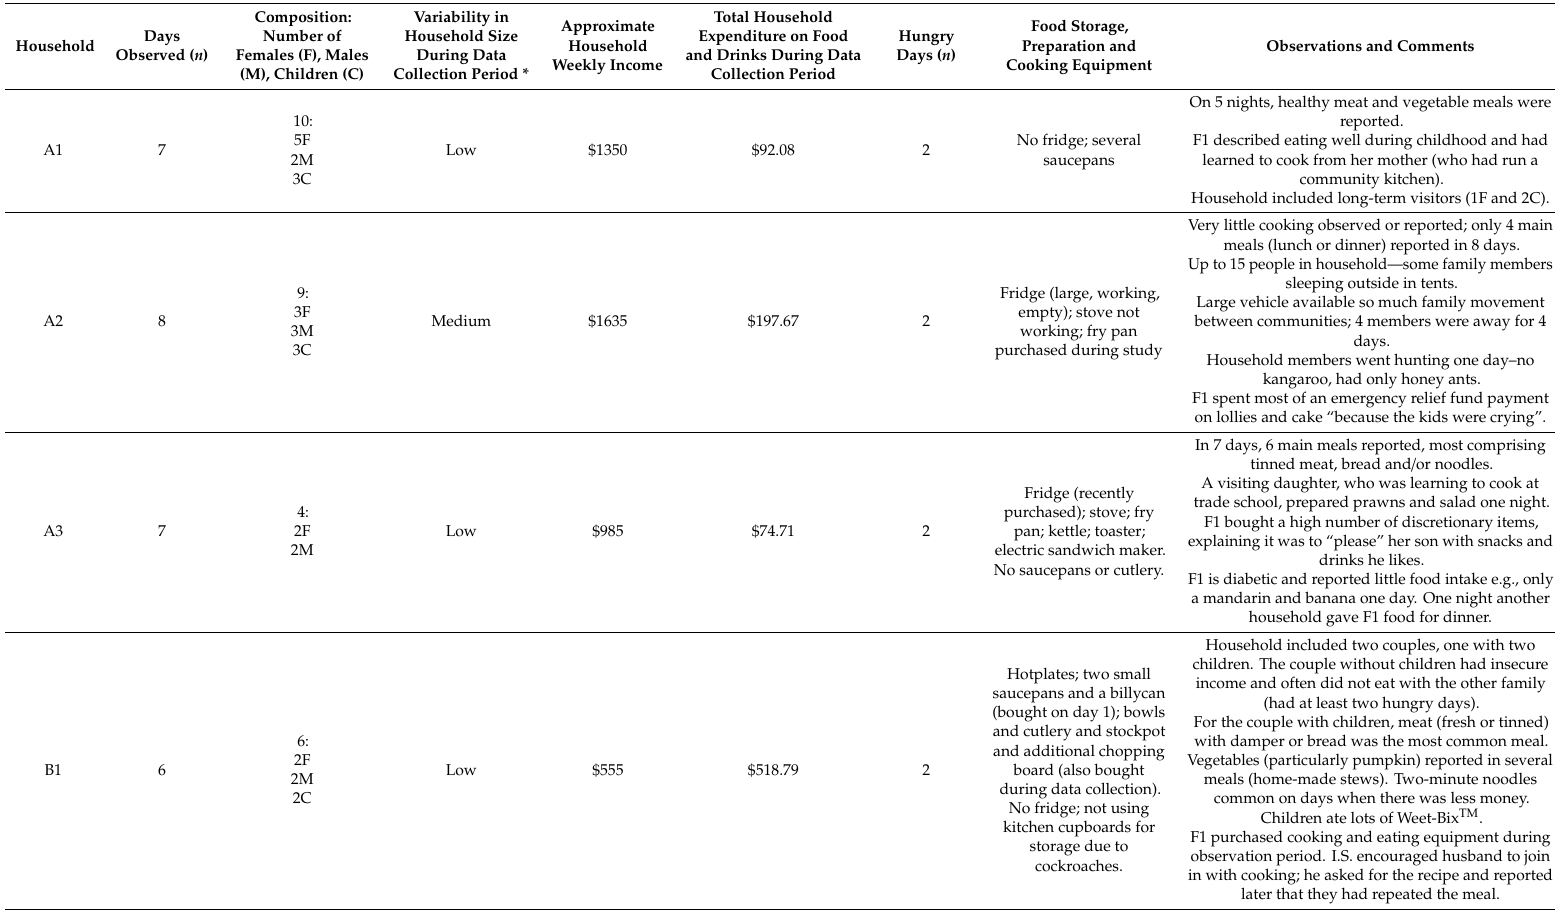
Table 1. Characteristics of participating households and observations of food